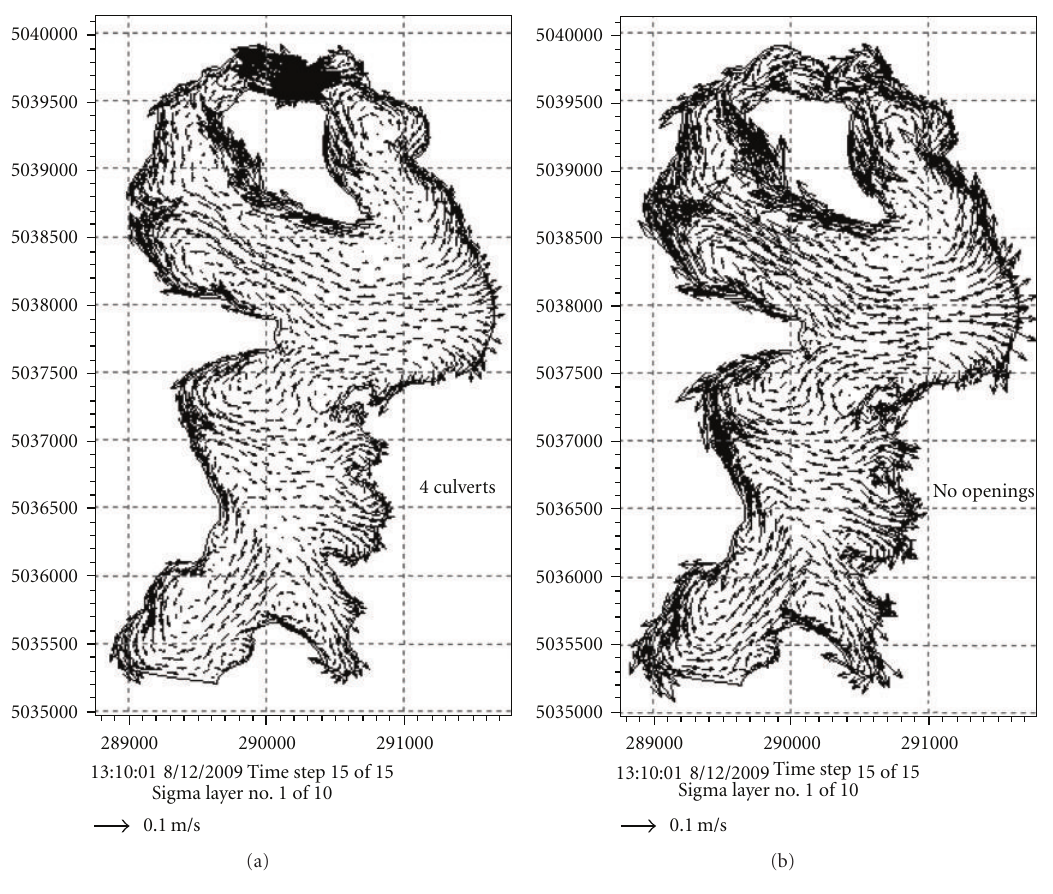
Figure 25: Comparison of the bottom flow patterns generated under 10 m/s constant east wind with the 4 inserted culverts and a closed